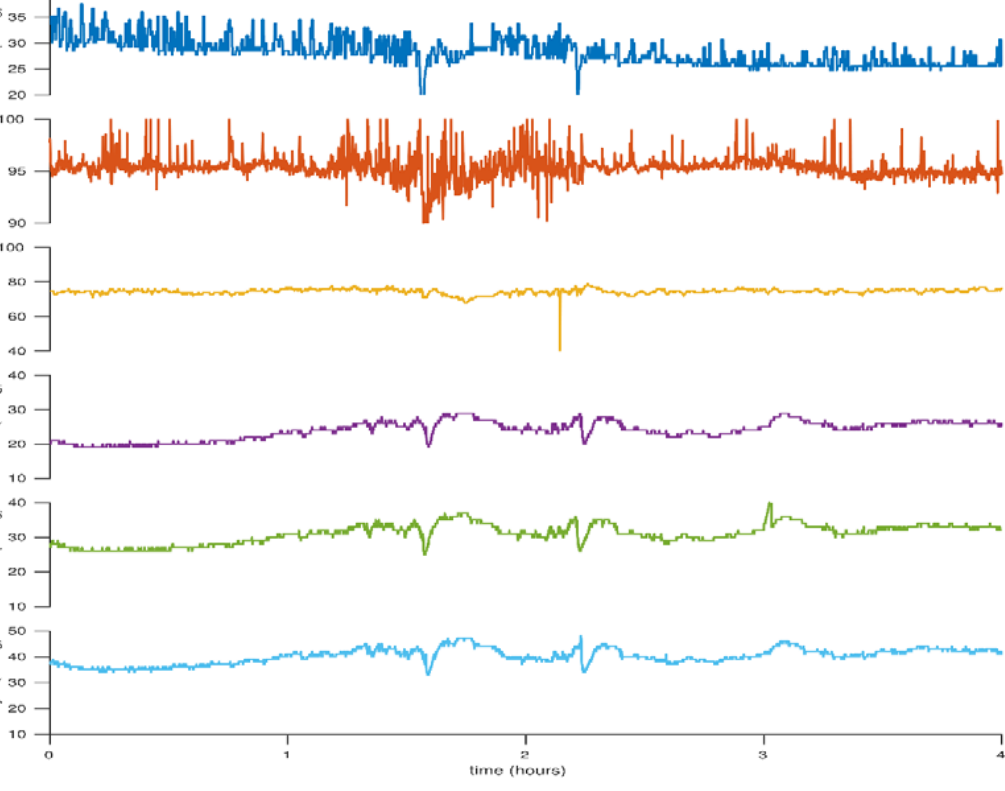
Figure 3. Cerebral rSO 2 remains stable despite changes in blood pressure. This figure reflects the case of neonate born at 24 + 5 weeks gestation. Birth weight (BW) 660 g, day of life (DOL)